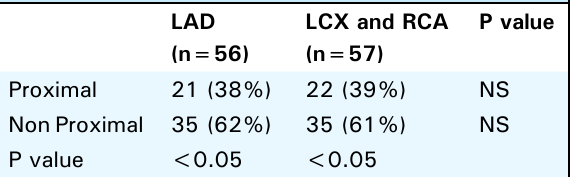
Table 5. Proximal and non proximal vessel stenting